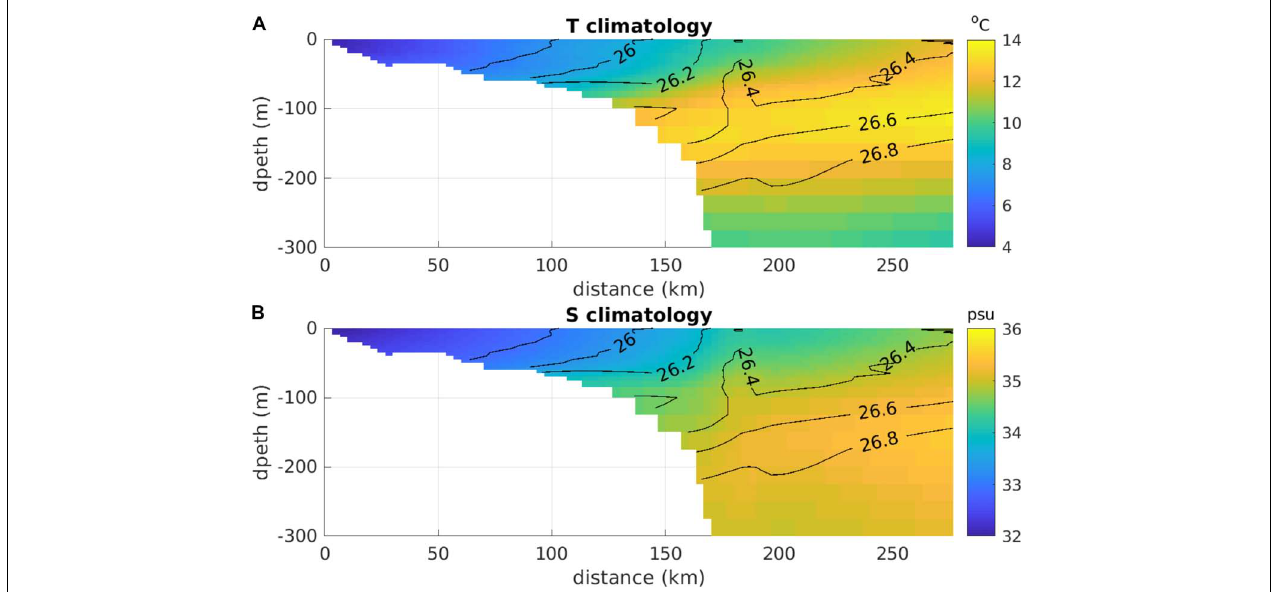
FIGURE 2 | Cross-shelf sections of Climatological mean temperature (A) and salinity (B) in January across the continental shelf and slope south of New England along 71 ◦ 00 (cid:48) West. The black contour lines indicate isopycnals. Units are Degrees Centigrade for temperature, Practical Salinity Units for salinity, and kg/m 3 for